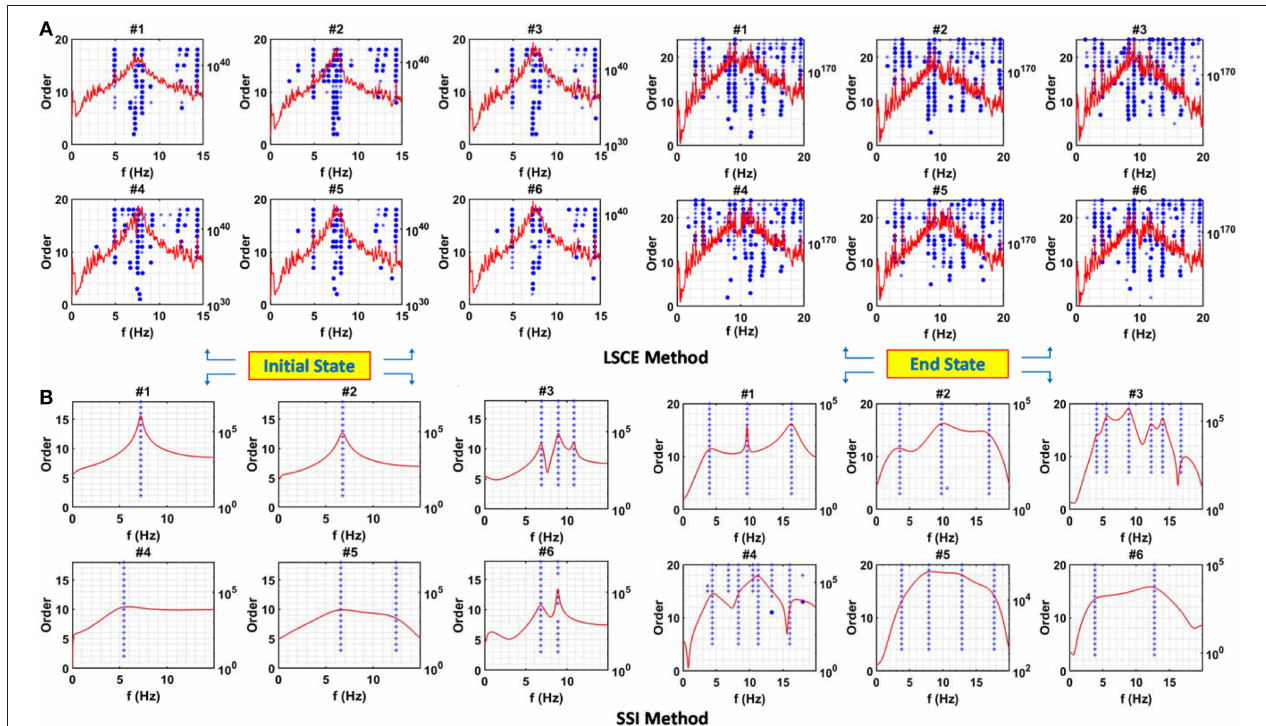
FIGURE 9 | Frequency response and stabilization diagram of the concrete girder bridge (Bridge #3) using (A) LSCE methods and (B) SSI methods before and after the seismic tests (initial and end states). The criteria are 1% for frequencies and 5% for damping ratios, symbols in stabilization diagram “*”indicates stable frequency and damping; “o” is stable frequency.